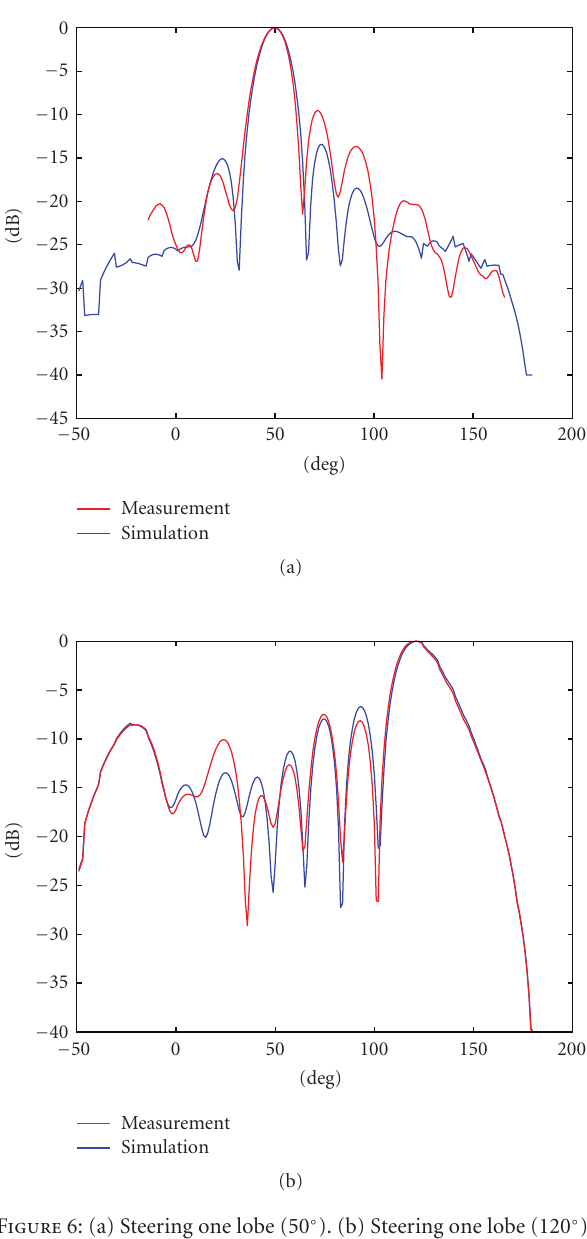
Figure 6: (a) Steering one lobe (50 ◦ ). (b) Steering one lobe (120 ◦ ).